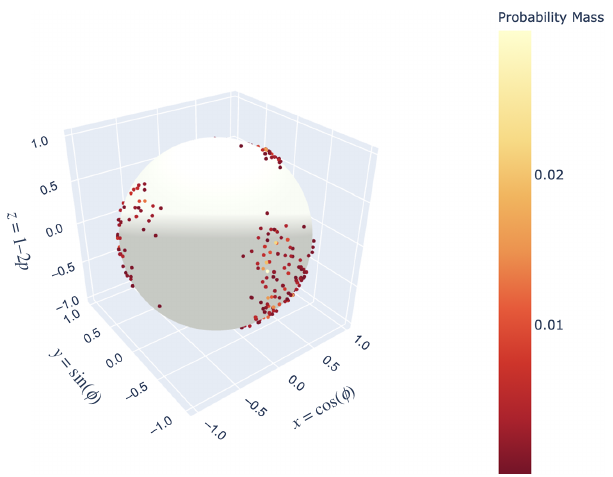
(cid:5) 2 9 p k δ [ Z − Z k ] k = 1